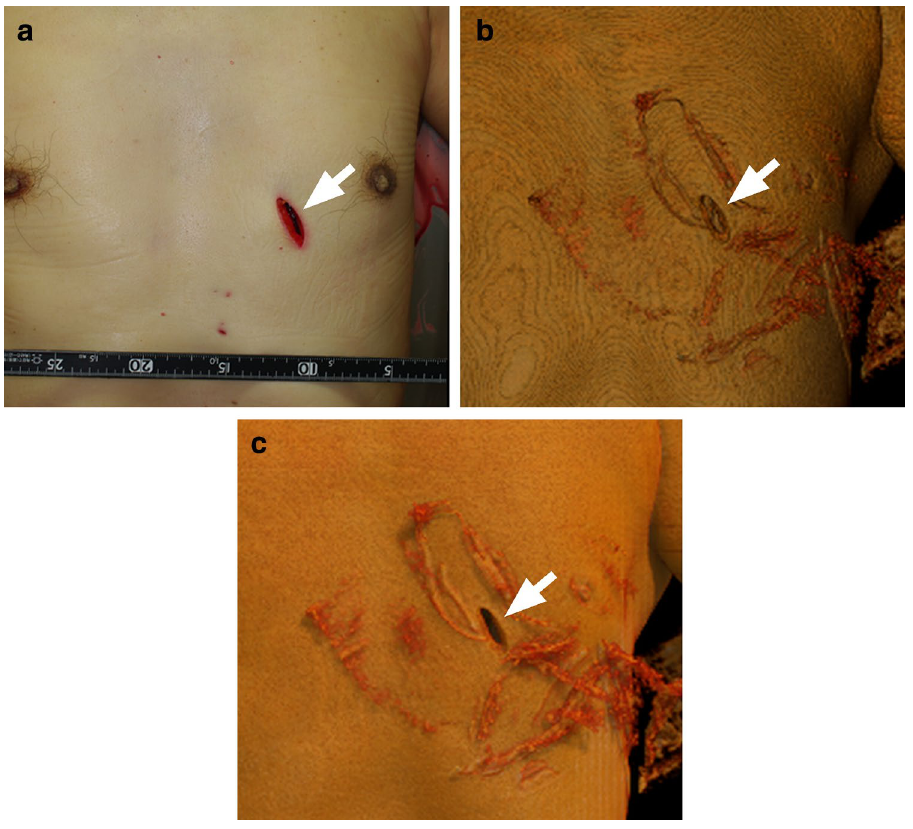
visualization of fine details including the wound